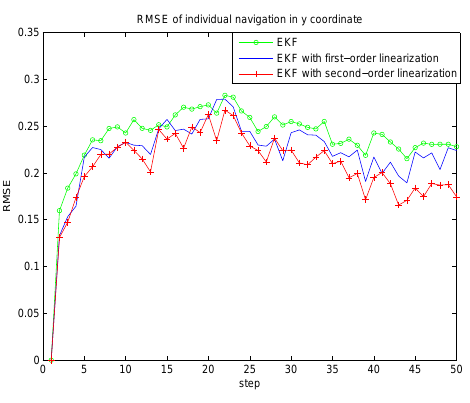
Figure 8. RMSE of individual localization in y